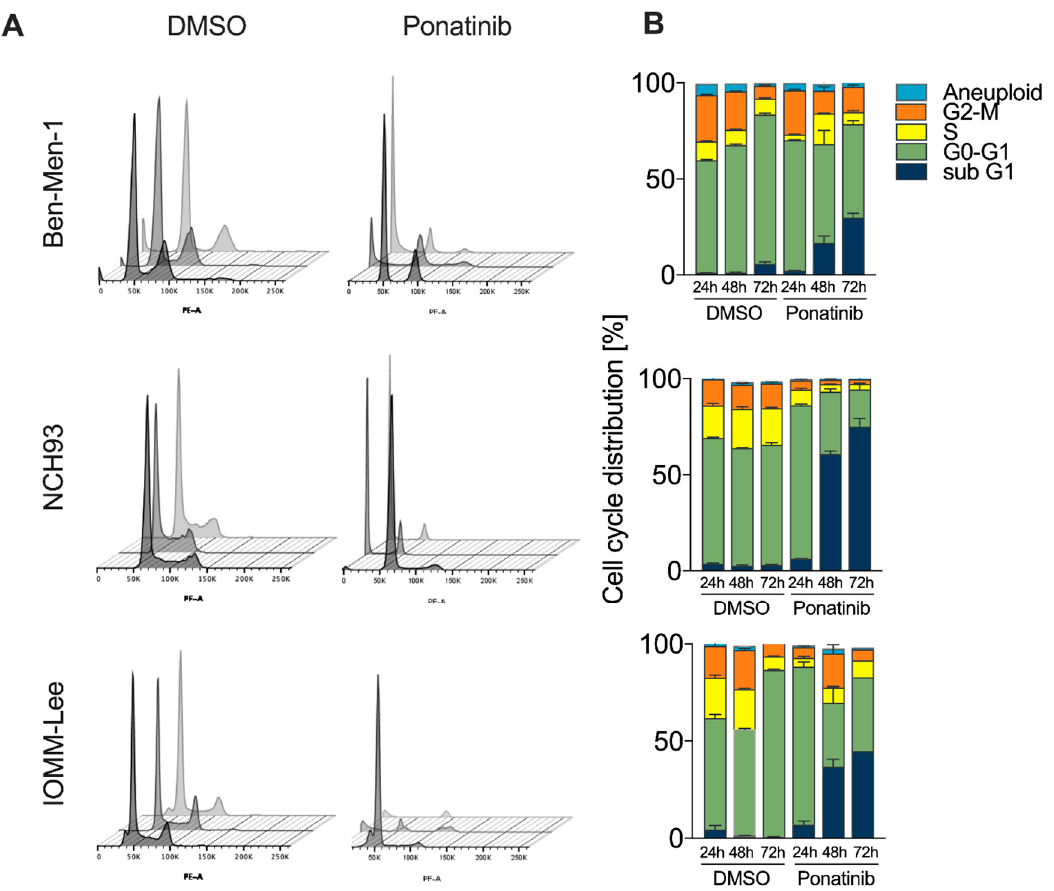
Figure 2. Ponatinib disrupts the meningioma cell cycle by induction of G0/1-arrest and subsequent accumulation of cells in subG1-phase: ( A ) Cell cycle distribution of meningioma cells treated with 10 × IC50 of ponatinib or DMSO after 24, 48, and 72 h. ( B ) Quantification of cell cycle distributions in meningioma cell lines. Each experiment was performed in triplicate and repeated three times. Results are expressed as mean ± SEM.